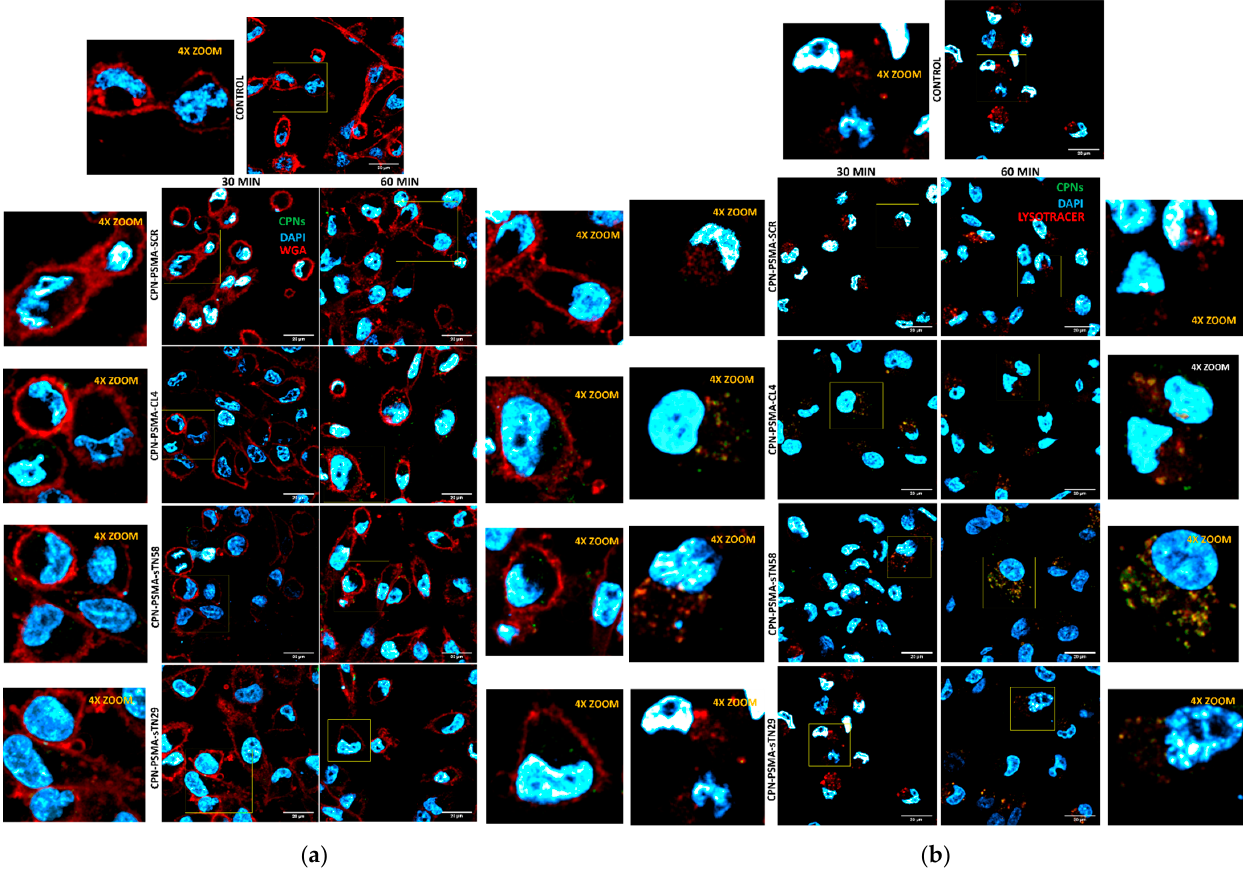
Figure 5. Intracellular localization of aptamer-decorated CPNs in TNBC cells. Representative confocal images of MDA-MB-231/cis cells exposed to 2 mg/L CPNs for 30 and 60 min and stained with WGA for cell membrane visualization ( a ) or LysoTracker Red for lysosome visualization ( b ). Altogether, these data clearly indicate that CL4, sTN29 and sTN58 aptamers specifi- cally deliver CPN to TNBC cells, strongly enhancing their intracellular uptake.